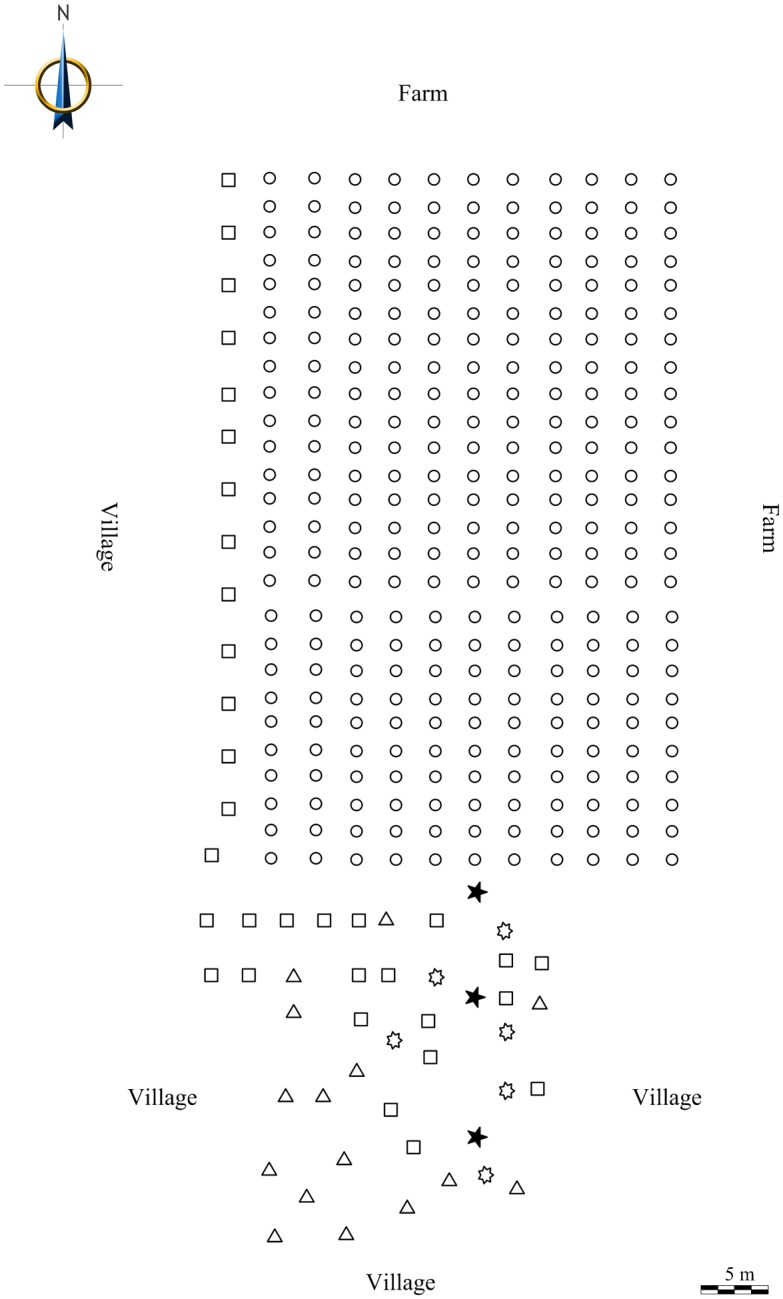
Map of study area.Circles represent sycamores, triangles represent poplars, squares represent elms, seven horns stars represent jujubes, and pentagram represent release points.